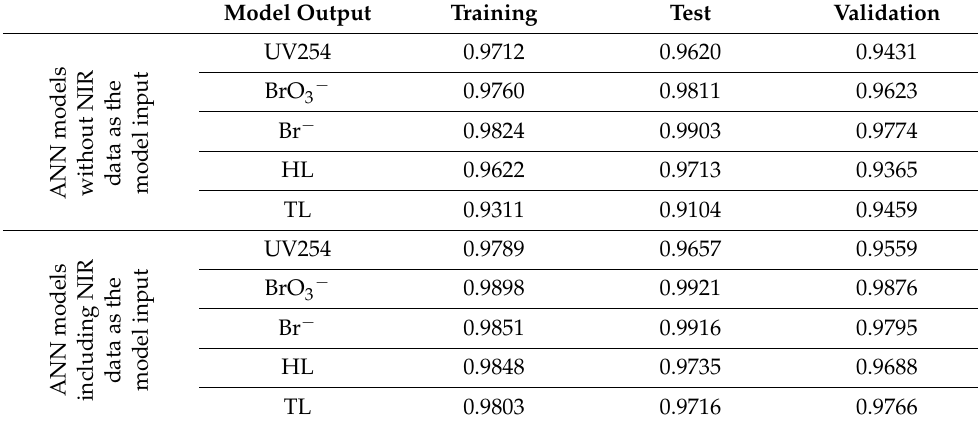
Figure 4. Comparison between experimental data and ( a ) MLR model prediction; ( b ) PLR model; ( c ) ANN models without NIR spectra and ( d ) ANN models with NIR spectra (1) UV254; (2) BrO 3 − ; (3) Br − ; (4) HL; and (5) TL. Table 5. Coefficients of determination of analyzed output variables based on selected